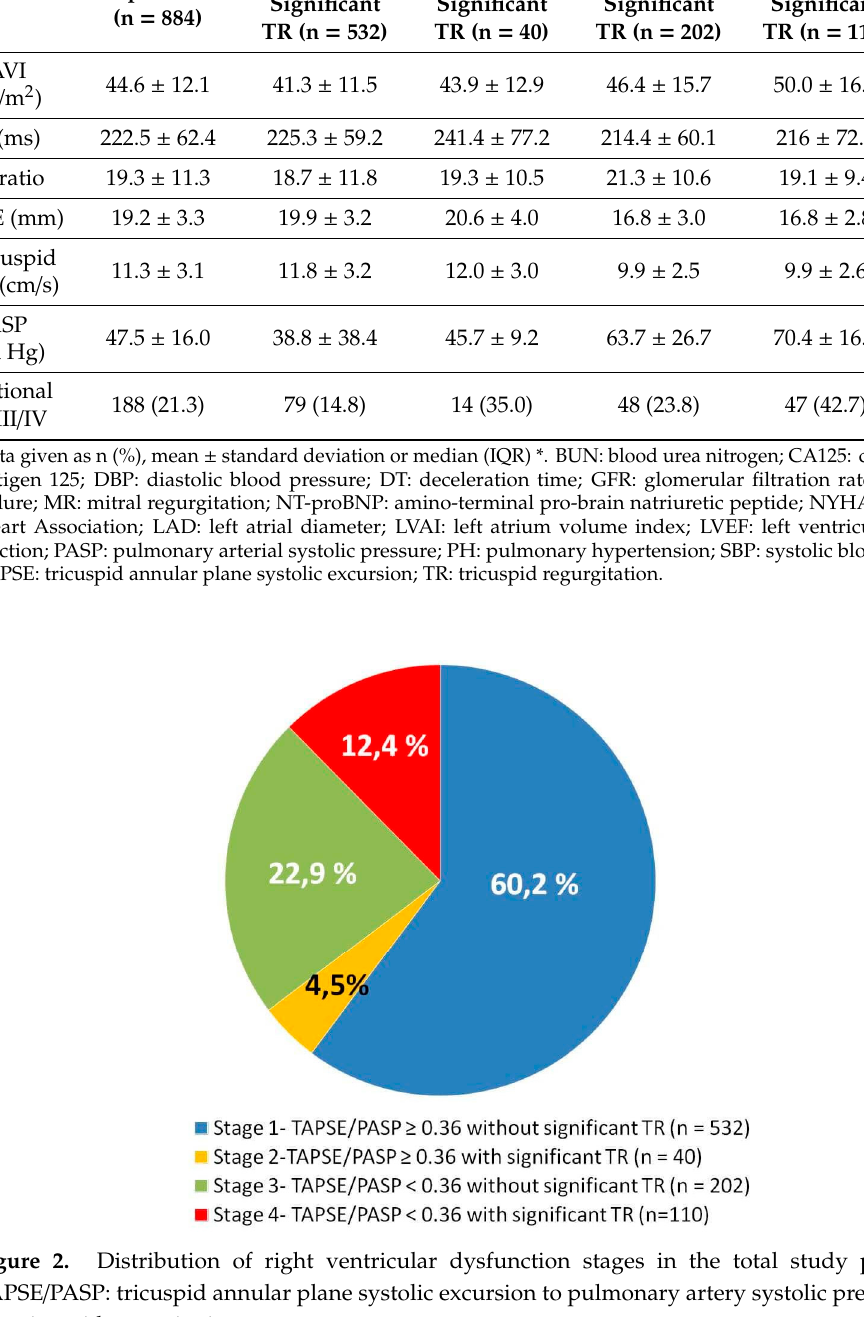
Table 1. Patient characteristics across right ventricular dysfunction stages.